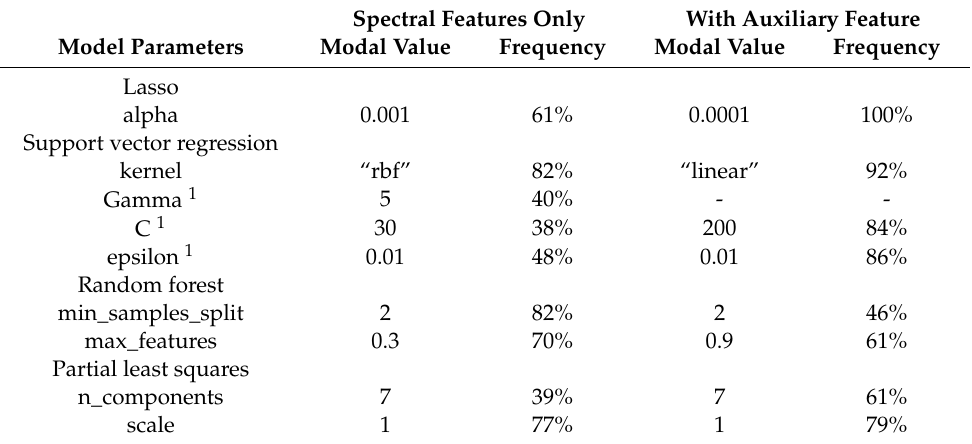
Table3. The mode andfrequency of themode across alltraining instances for the tuned hyperparameters in each of the prediction models. Hyperparameter tuning results are listed for the analysis that used spectral features only, as well as the analysis that used spectral features in addition to the auxiliary feature. The hyperparameters and their values are listed according to the conventions of the scikit-learn function arguments